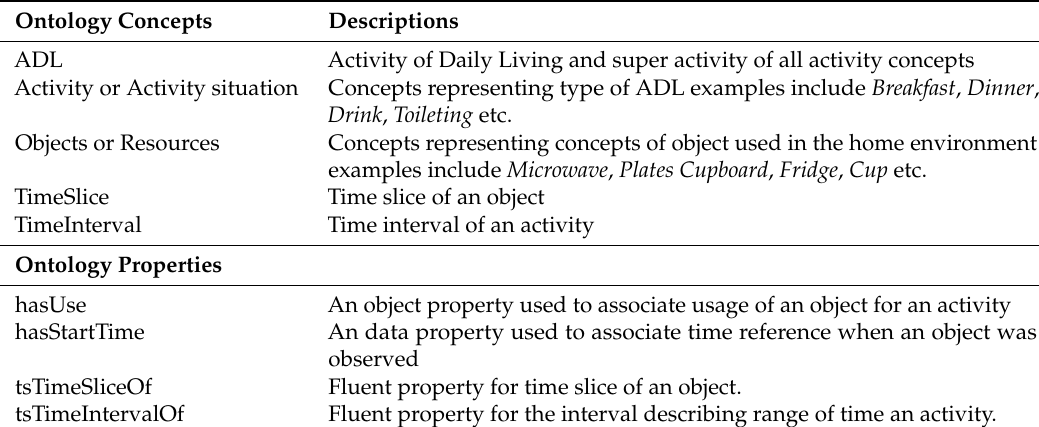
Table 1. Ontology concepts